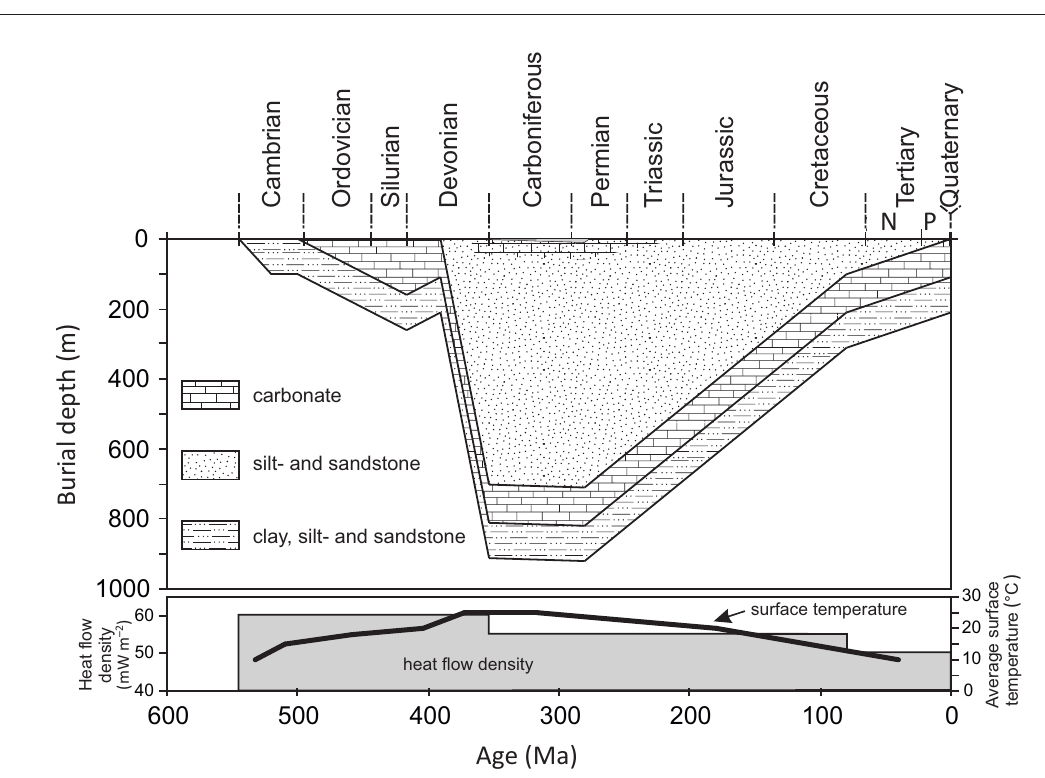
Fig. 5. Reconstruction of the burial history of the lower Cambrian Blue Clay in the northern Baltic